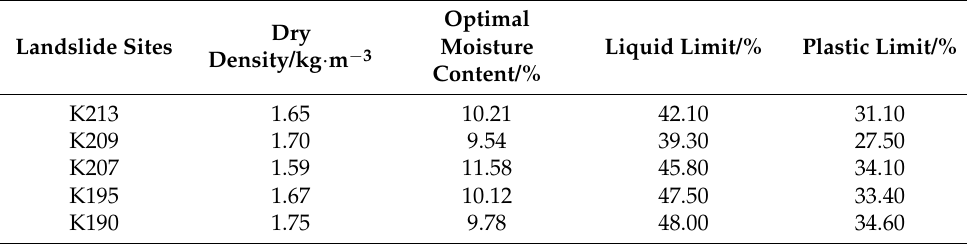
Figure 1. Location of the study area and landslide grouping. Table 1. C-M-S physical